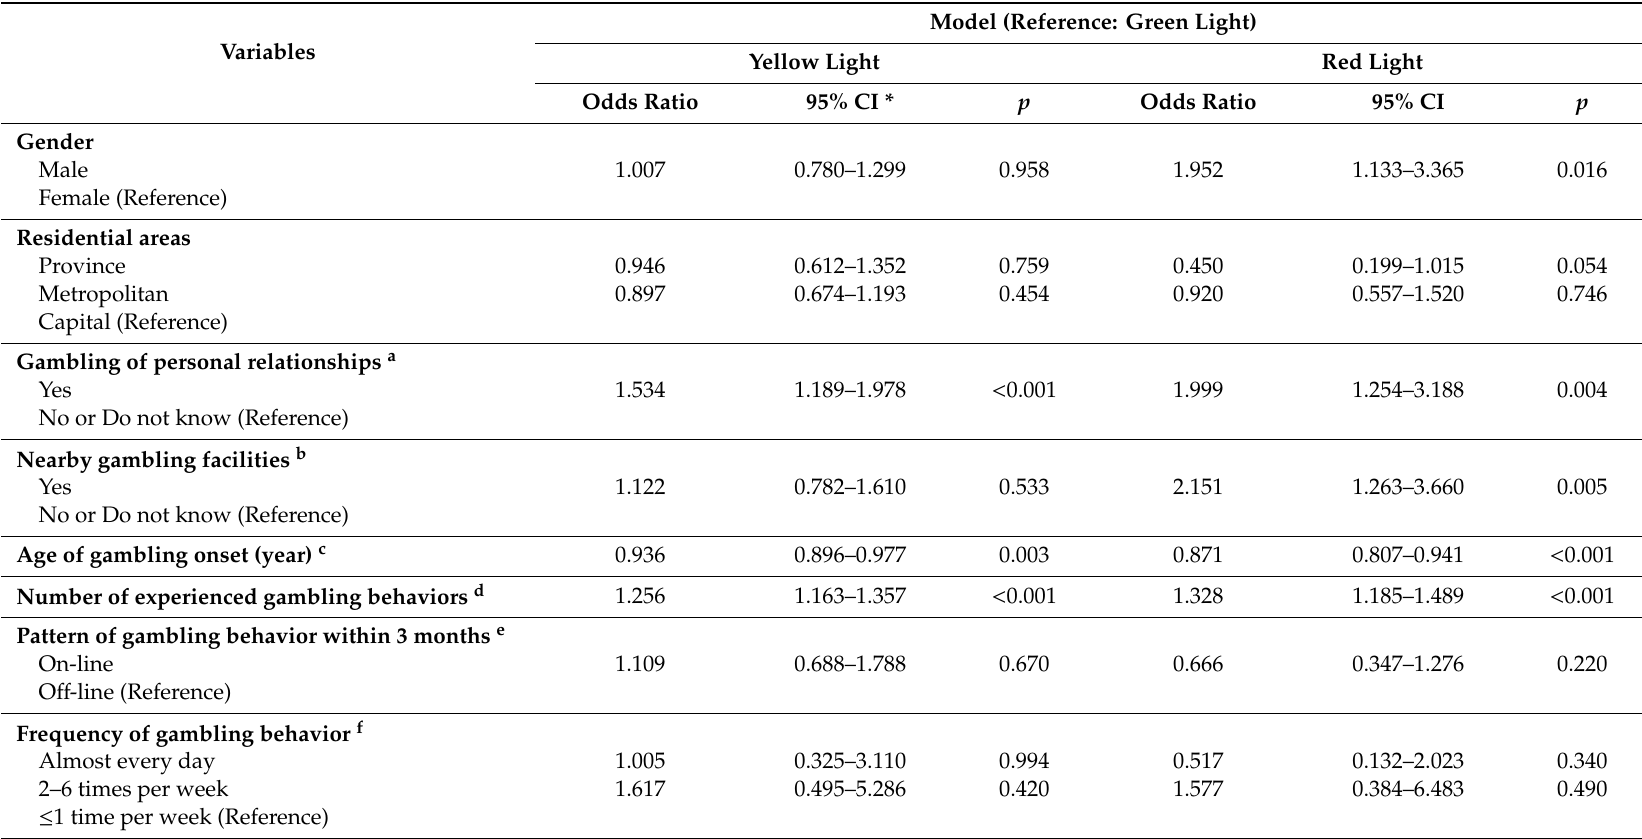
Table 3. Multinomial regression for gambling factors related with the level of adolescent problem